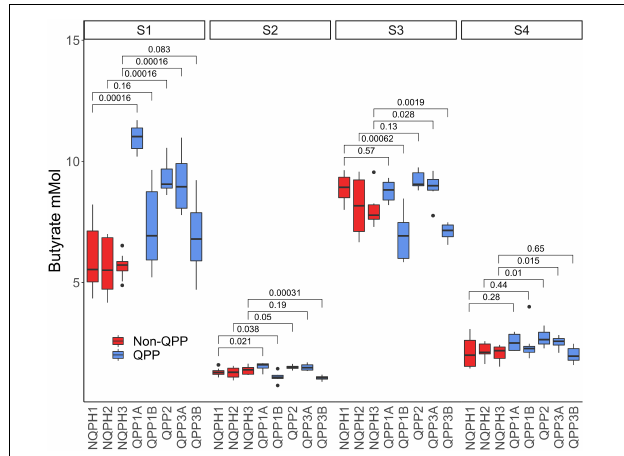
FIGURE 3 | Butyrate concentration in microbiomes of the four subjects post treatment with QPP and NQPH lines and comparisons (Wilcoxon) between hybrid pairs. Red boxes denote hybrid pairs where the microbiome treated with a QPP hybrid has significantly less butyrate than the NQPH control.